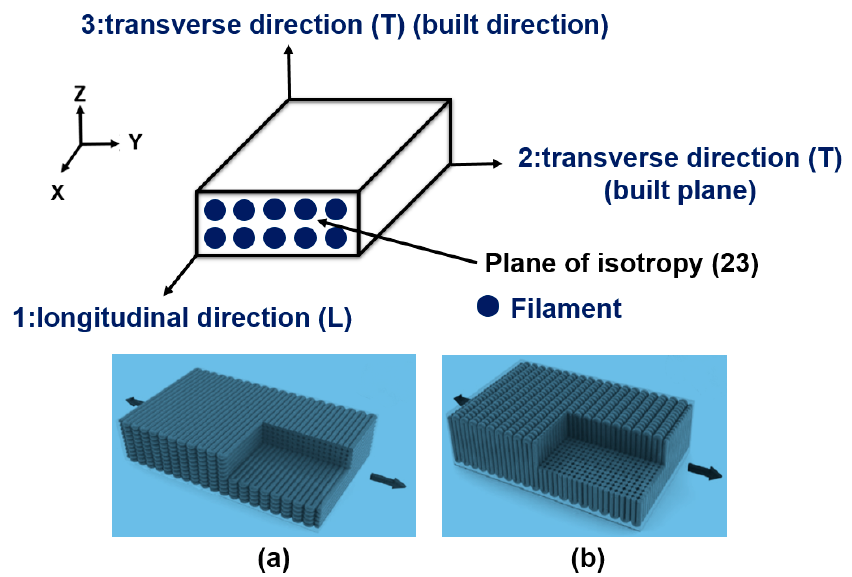
Figure 4. Transverse isotropic behavior for 3D printed parts; 1 is the longitudinal direction of the filaments, 2 is the transverse direction in the built plane illustrated in ( a ) and 3 is the second transverse direction that represents the built direction ( b ) [25].